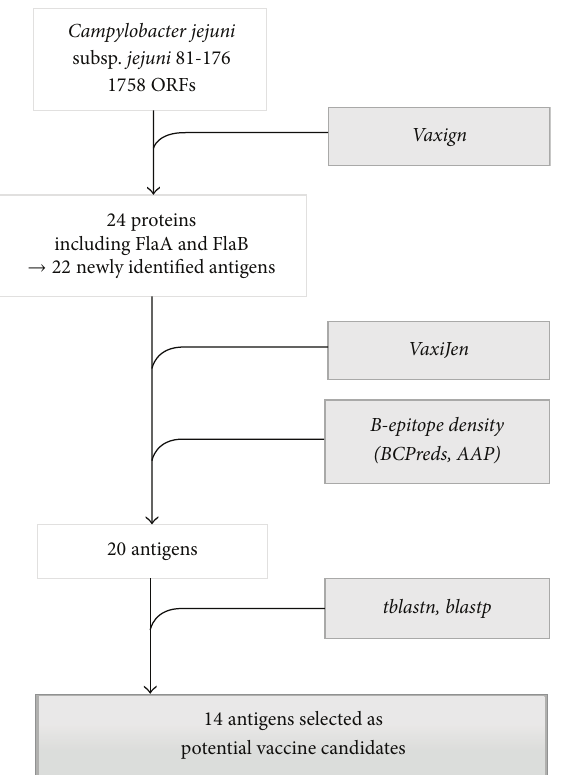
Figure 1: Summary of the reverse vaccinology protocol applied to Campylobacter jejuni for the selection of vaccine